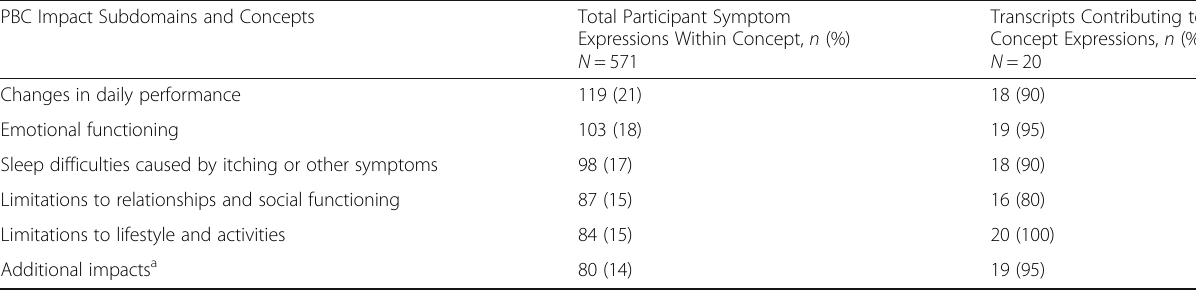
Expressions Within Concept, n (%) N = 571